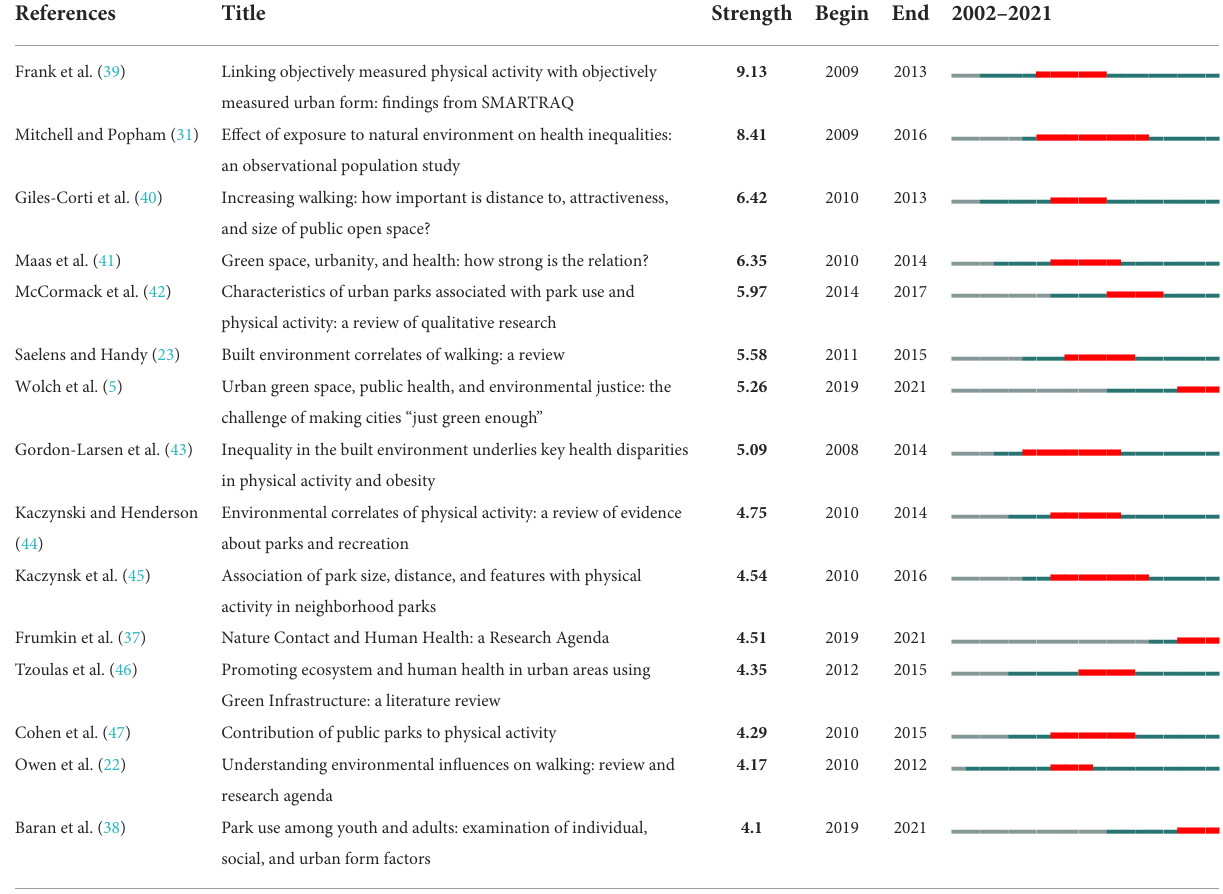
TABLE 7 Top 15 references with the strongest citation bursts in WoSCC database from 2002 to